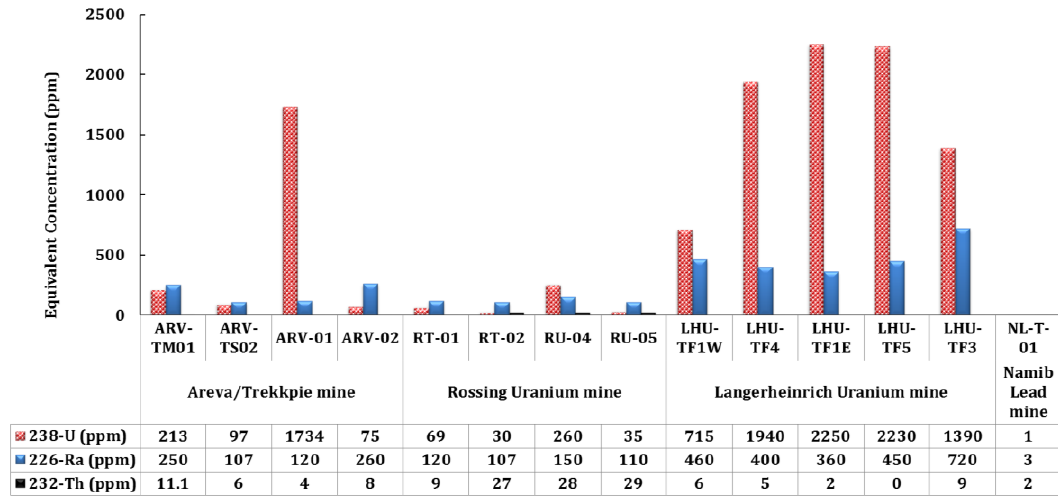
Figure 3. Equivalent concentration of the uranium and its decay products in the Erongo region [2], Reproduced with permission from I. Shaduka.